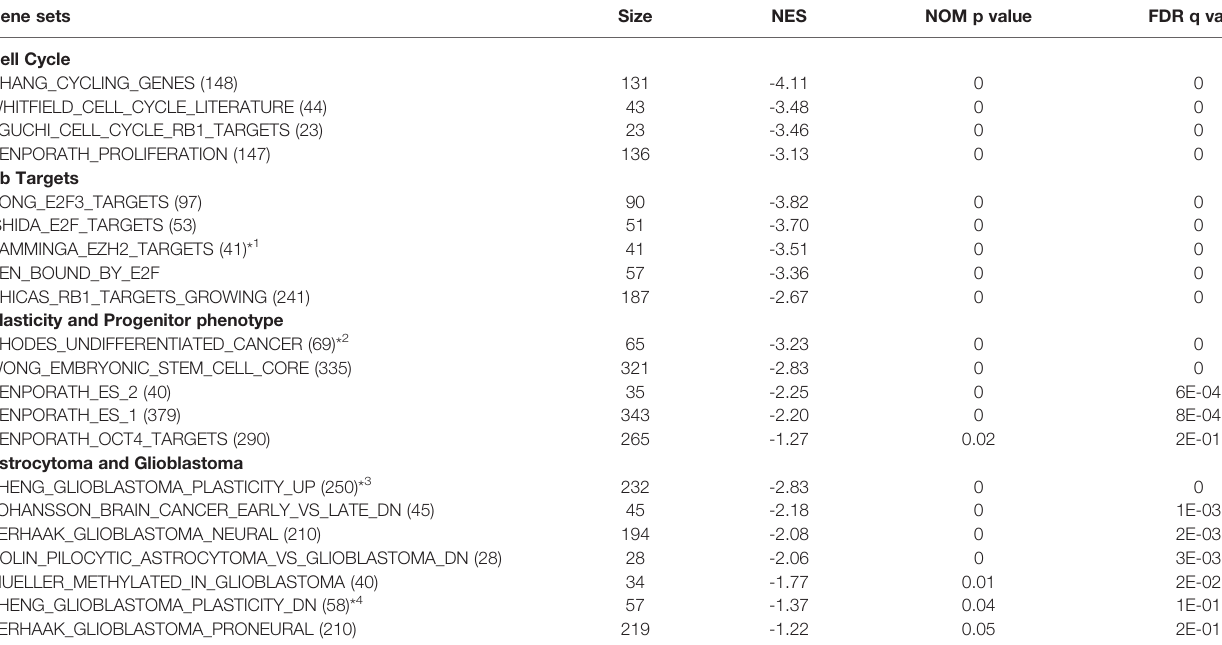
TABLE 2 | GSEA data showing gene data sets upon Rb-TS inactivation. Gene